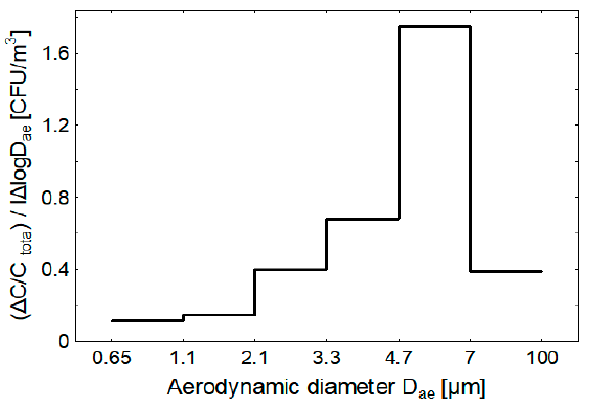
Figure 5. Size distribution of bacterial aerosols recorded at the maximum UV radiation value (886 W/m 2 ).